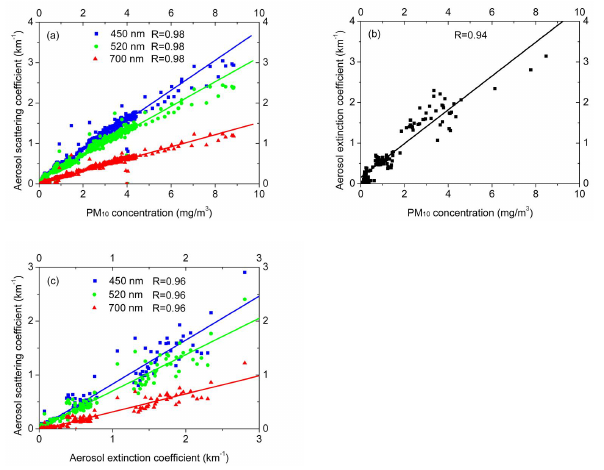
Fig. 11. Correlations of dust aerosol extinction coefficient, scattering coefficient, and PM 10 concentration. All the correlation coefficients between aerosol scattering coefficients at 450, 520, and 700 nm and PM 10 concentration were 0.98 (see Fig. 11a). The correlation coefficient of aerosol extinction coefficient retrieved by lidar at the wavelength of 532 nm and PM 10 concentration, of aerosol scattering and extinction coefficient were respectively 0.94 and 0.96 (see Figs. 11b and c).